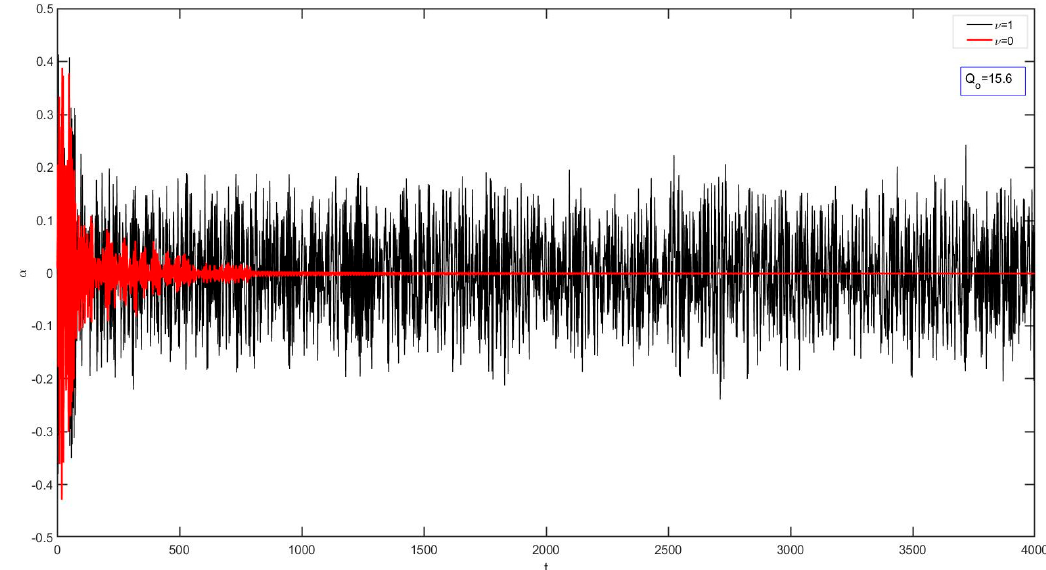
ff ect of noise on torsional displacement with active control. Fluids 2020 , 5 , x FOR PEER REVIEW